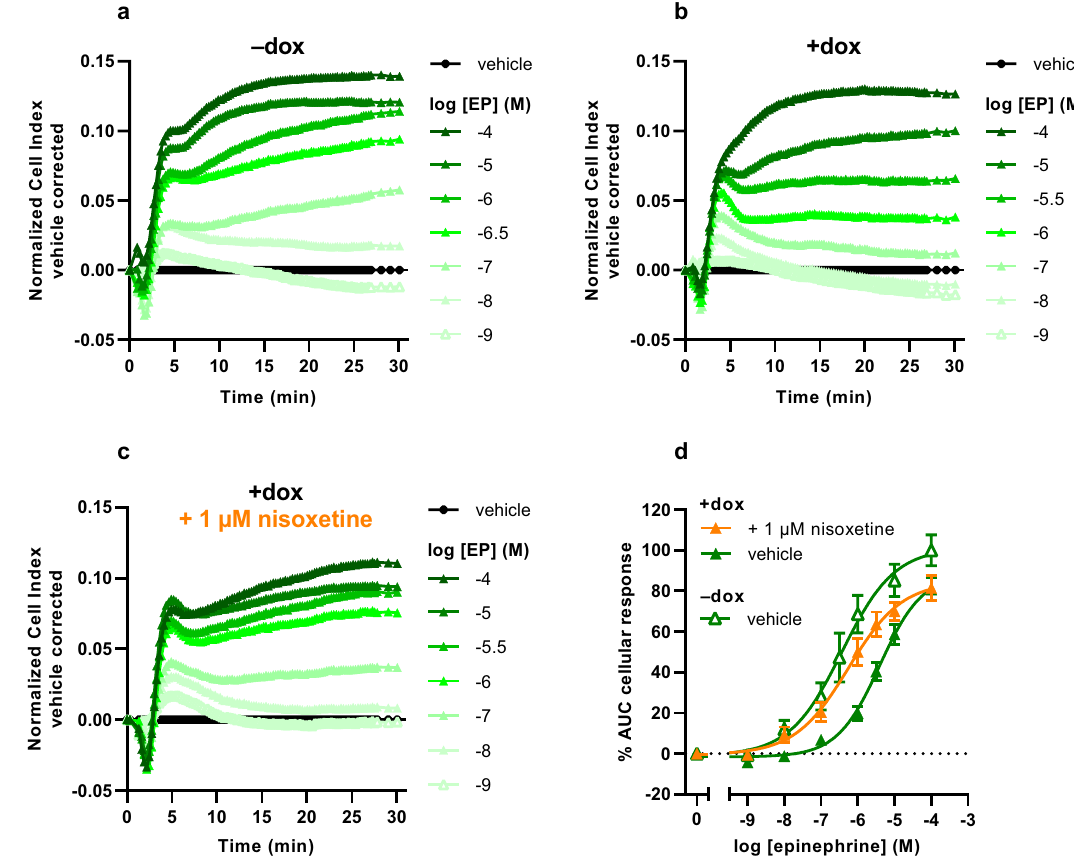
Figure 3. Characterization of the epinephrine (EP) response on JumpIn-NET cells in the TRACT assay. Representative vehicle-corrected normalized Cell Index traces of vehicle-pretreated JumpIn-NET cells ( a ) in the absence (−dox) or ( b ) in the presence of 1 µg/ml dox (+dox). ( c ) Dox-treated cells were pretreated for 1 h with 1 µM nisoxetine prior to stimulation with EP. ( d ) Combined concentration-effect curves of EP on vehicle- or dox-treated JumpIn-NET cells. Cellular response is expressed as the net AUC of the first 30 min after stimulation. Data are normalized to the response of 100 µM EP on vehicle-treated (−dox) cells. Data are shown as the mean ± SEM of three to six individual experiments each performed in